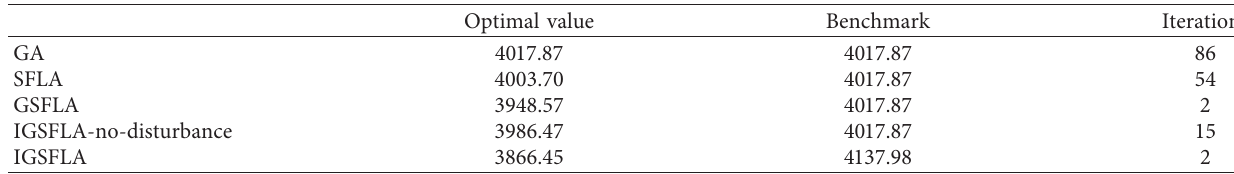
Figure 13: Convergence comparison graph (unit: second). Table 5: Convergence comparison (unit: